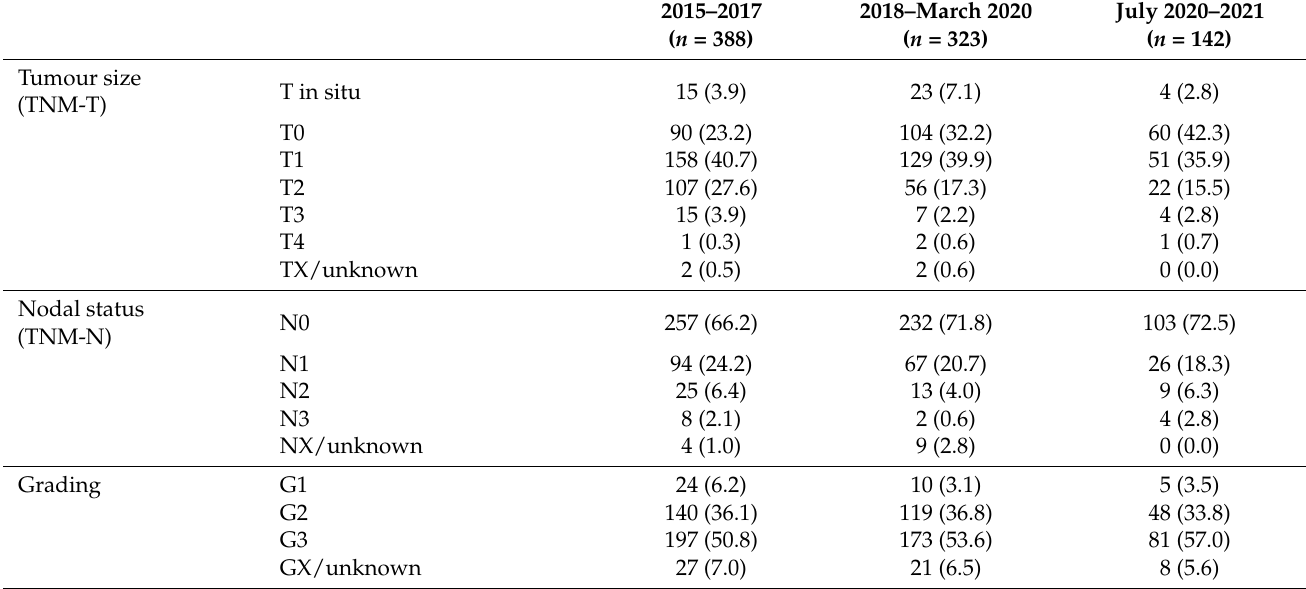
Table 2. Clinical characteristics of young adult non-metastatic breast cancer patients with minor children participating in a 3-week inpatient mother–child rehab program according to time of rehab